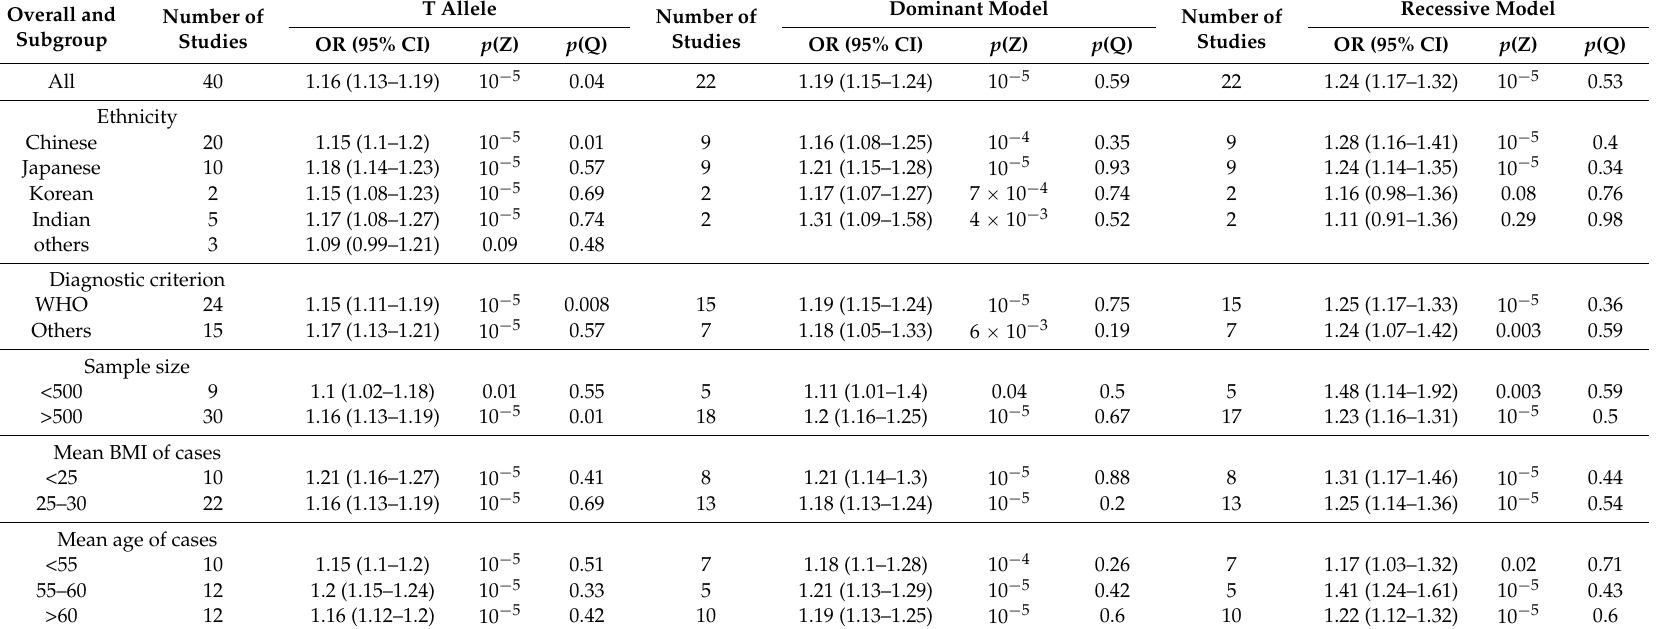
Table 3. Results of meta-analysis for IGF2BP2 rs4402960 polymorphism and